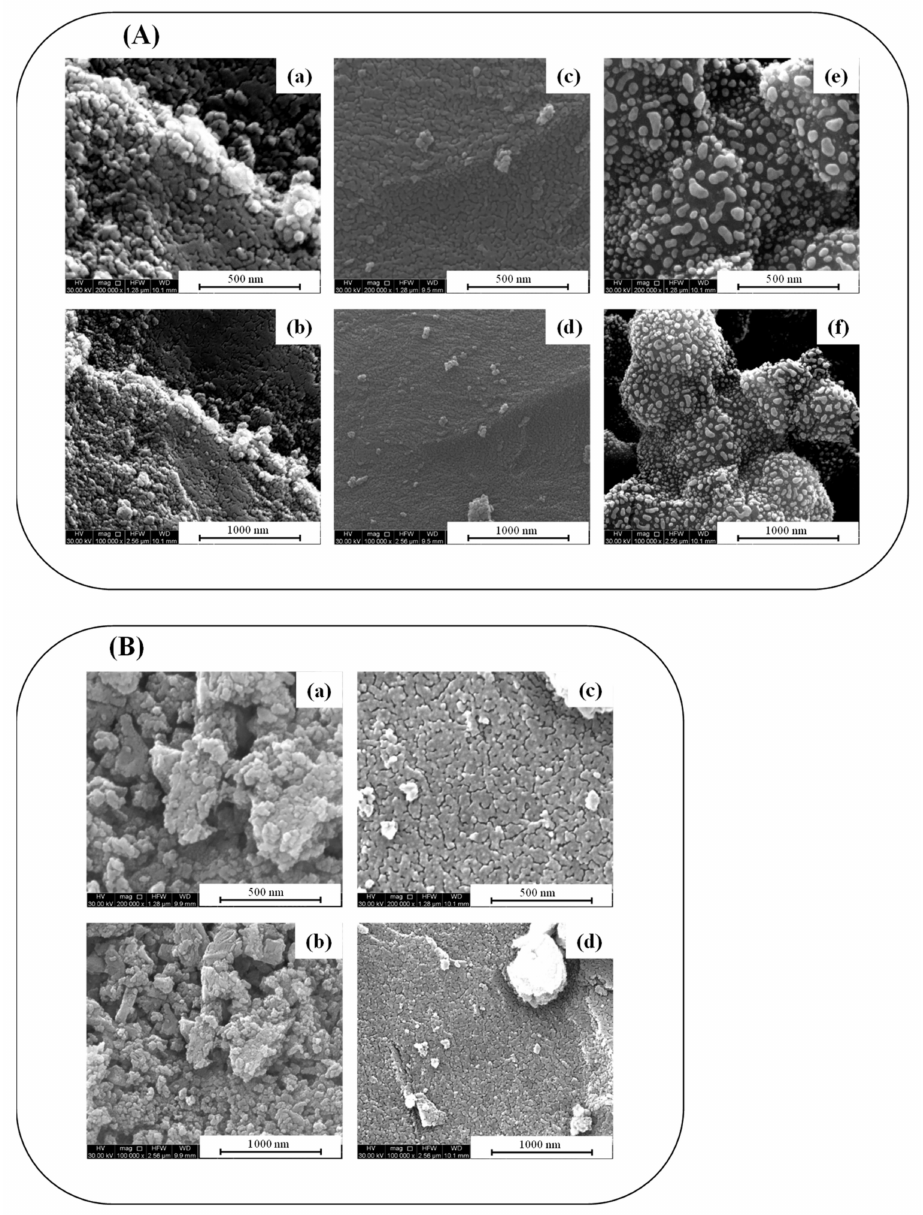
Figure 2. SEM micrographs of each prepared powder at two different magnifications, 10 5 and 2 · 10 5 : ( A ) bare Nb 2 O 5 ( a , b ), Nb 2 O 5 /TiO 2 ( c , d ) and bare TiO 2 ( e , f ) and ( B ) Nb 2 O 5 /CeO 2 ( a , b ) and Nb 2 O 5 /ZrO 2 ( c , d